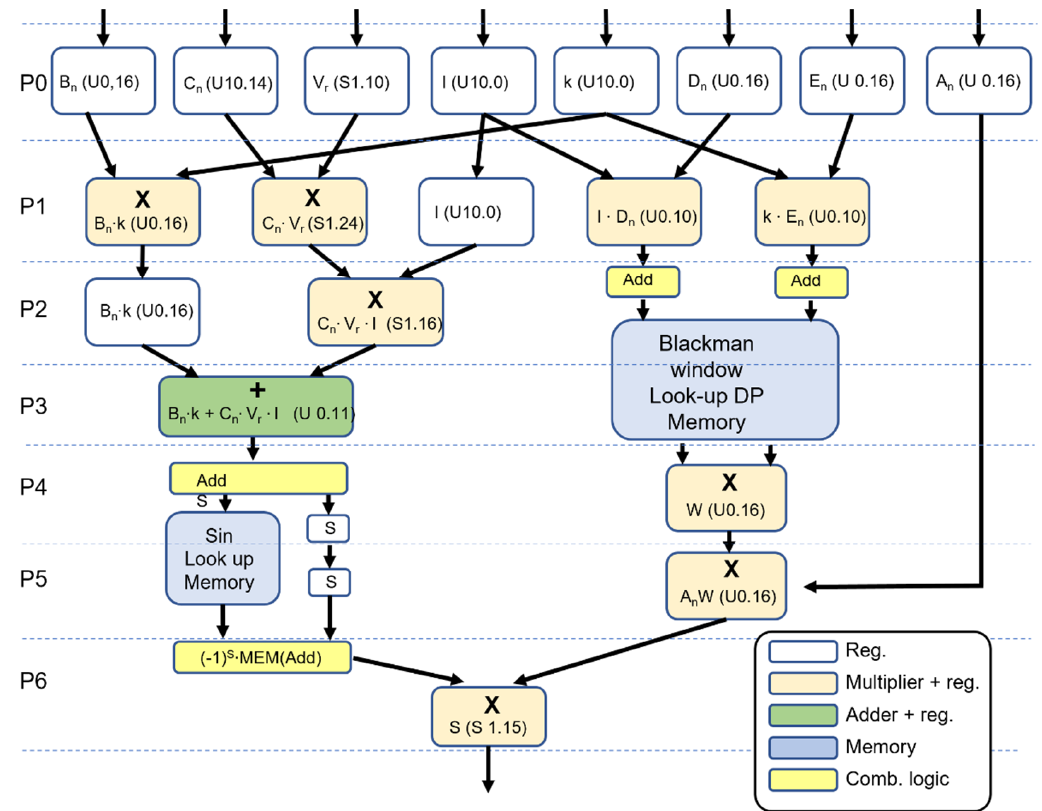
Figure 1. Pipeline of the scatterer generator.